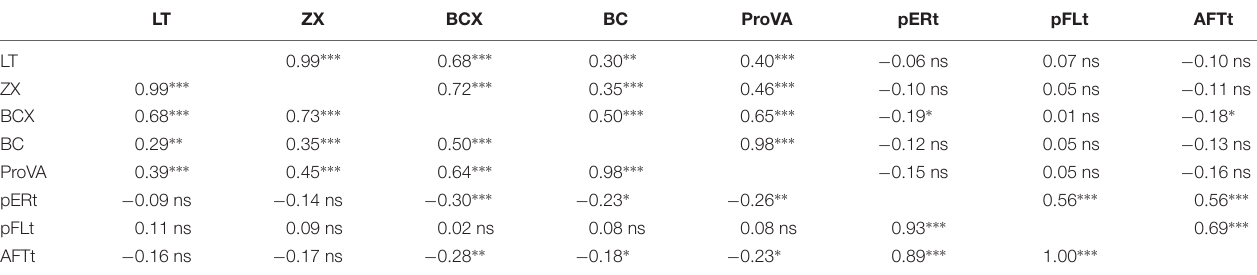
TABLE 7 | Pearson phenotypic correlation (above diagonal) and genotypic correlation (below diagonal) coefficients and among carotenoid and aflatoxin traits for F2 grain of 120 hybrids grown at four environments. LT ZX BCX BC ProVA pERt pFLt AFTt LT